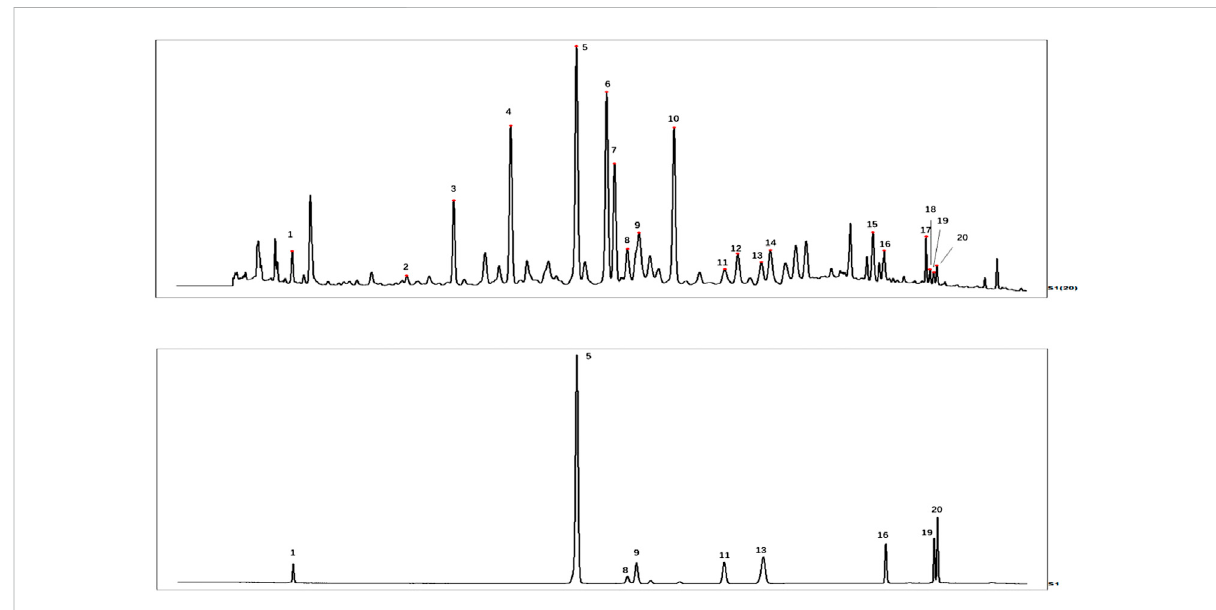
TABLE 1 Histopathological scoring criteria of liver tissue and synovial membrane of alcoholic liver injury combined with gouty arthritis. liver tissue Synovial tissue Score The cell structure was normal, and there was no in fl ammatory cell in fi ltration Synovial tissue with smooth edges and no in fl ammatory cells 0 Cell structure is normal, with a small amount of in fl ammatory cell in fi ltration A small number of in fl ammatory cells Cell structure without obvious abnormalities, a large number of in fl ammatory cell obvious vascular congestion in fi ltration Fat vacuoles A large number of in fl ammatory cells, local in fl ammatory cell in fi ltration Clusters of in fl ammatory cell in fi ltration and alarge number of fat vacuoles were recorded In fl ammatory cells were gathered in clusters, and the cells were scattered The structures of hepatic lobules were unclear and the nuclei disappeared Synovial hyperplasia and tissue necrosis